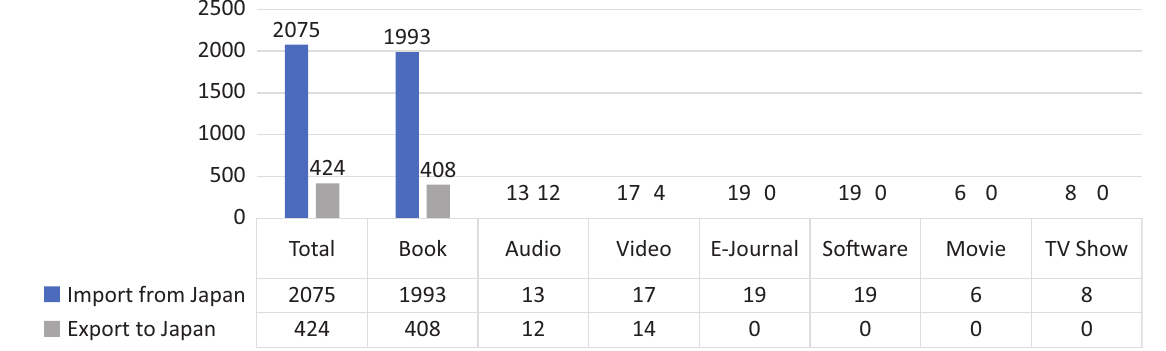
Figure 1. Copyrights import and export by media genre in China 2018. Note: Unit = piece. Source: National Bureau of Statistics of China (2019).